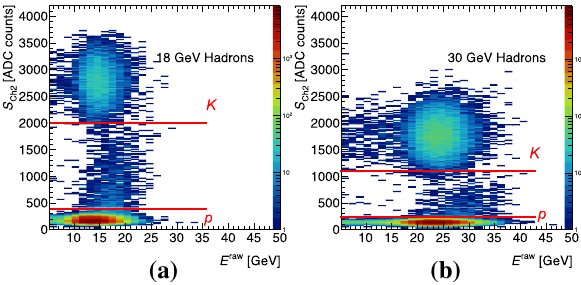
Fig. 13 Scatter plot of the Ch2 signals, S Ch2 , in ADC counts units, vs the energy measured in the calorimeter E raw obtained by analyzing K / p sample events produced by beams of particles with energy equal to 18 ( a ) and 30 ( b ) GeV. The cut values applied in the analysis to select kaon and proton events are shown. The color scale indicates the number of events in the